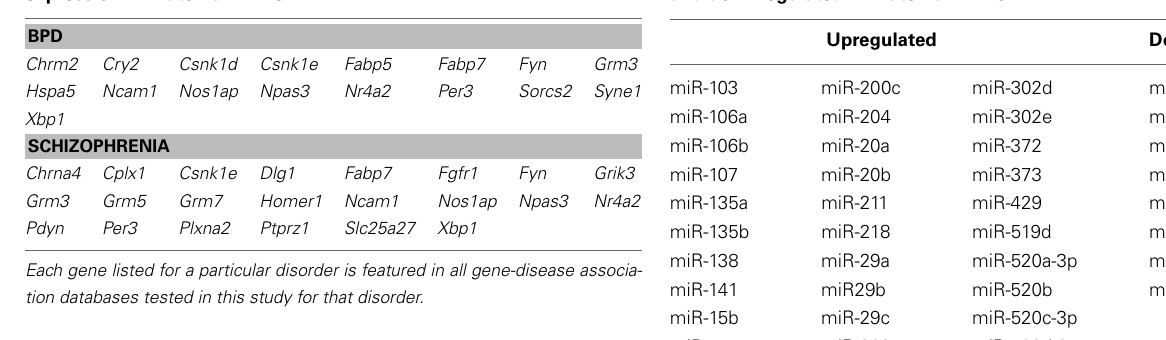
matches were found in the actual significant maternal mPFC expression changes and where that number falls on the probability density distribution. The enrichment p -value is derived from the number of simulated results that contained at least as many matches to database as the actual results.